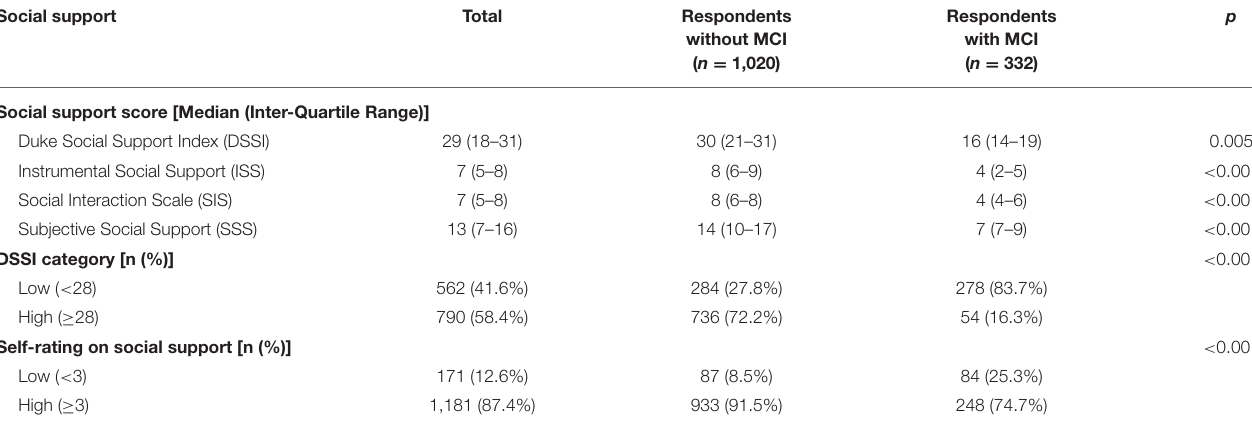
TABLE 2 | Social support for the study participants with and without MCI ( n =